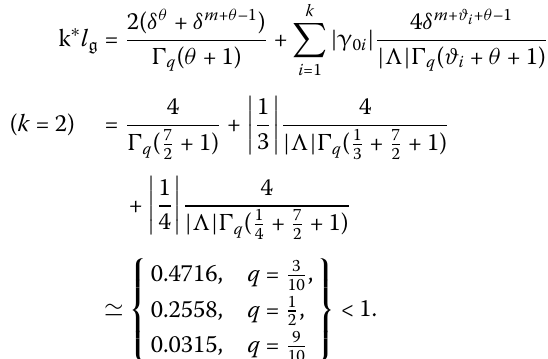
} in Example 5.1 , 1 , 9 10 2 10 q = 9 10